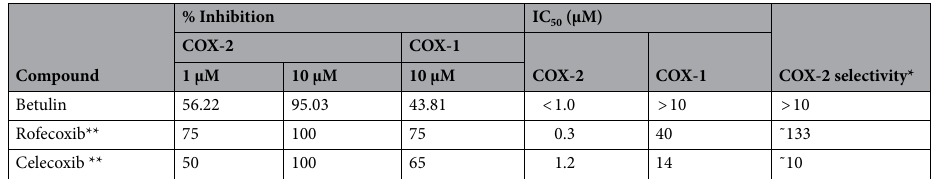
Table 4. Cyclooxygenase enzyme mediated anti-inflammatory activities (COX-1 & COX-2) of “Betulin “isolated from bark of Acacia nilotica. *COX-2 selectivity = IC 50 (COX-1)/ IC 50 (COX-2). **Reported in literature (Kaur et al., 2009) 22